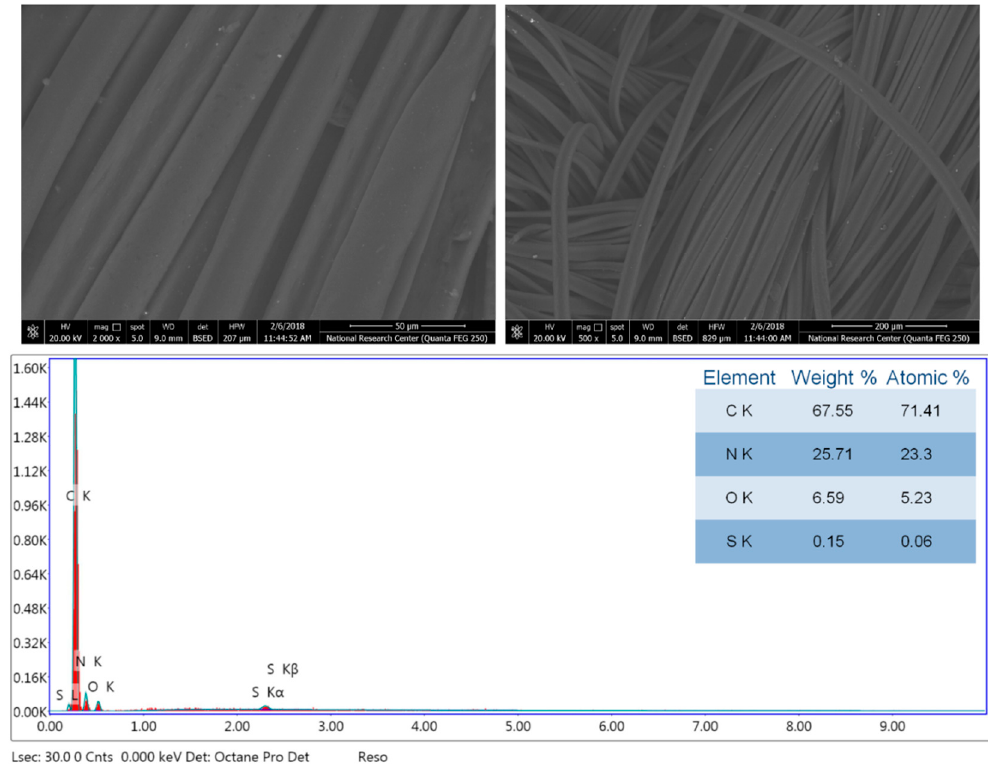
Figure 7. SEM images and EDX diagram of blank/untreated acrylic fabric.